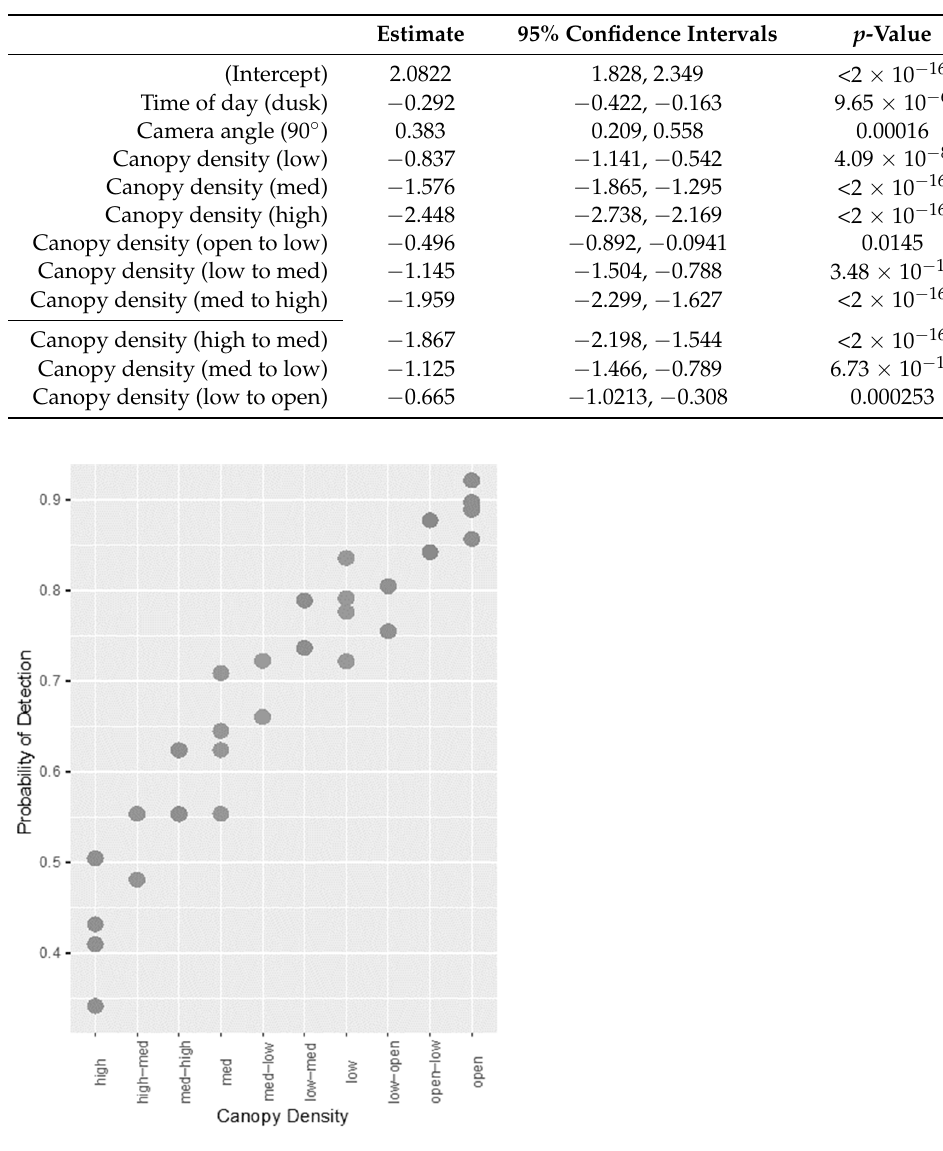
Figure 1. Scatterplot showing the relationship between increasing canopy density and probability of detection for TIR images with manual detection.